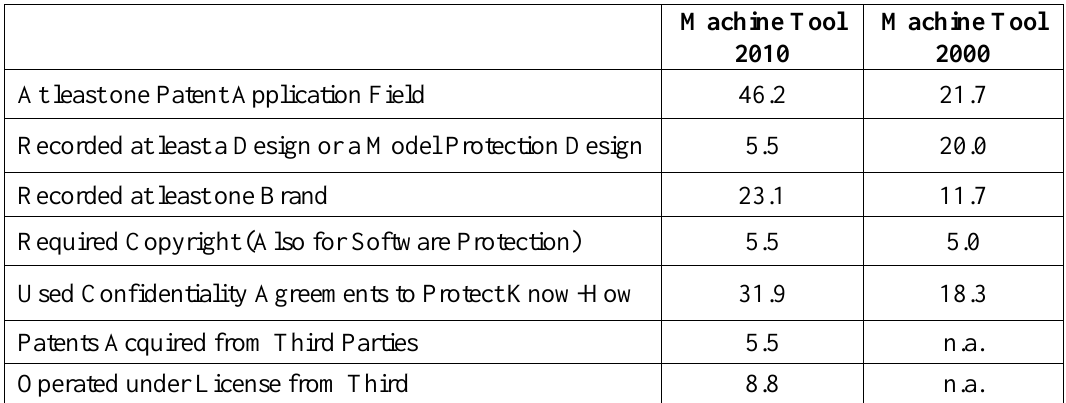
Table 5: The Adoption of Instruments of Protection of Company Know-How in the Last Three Years (% of Total Enterprises, Several Answers